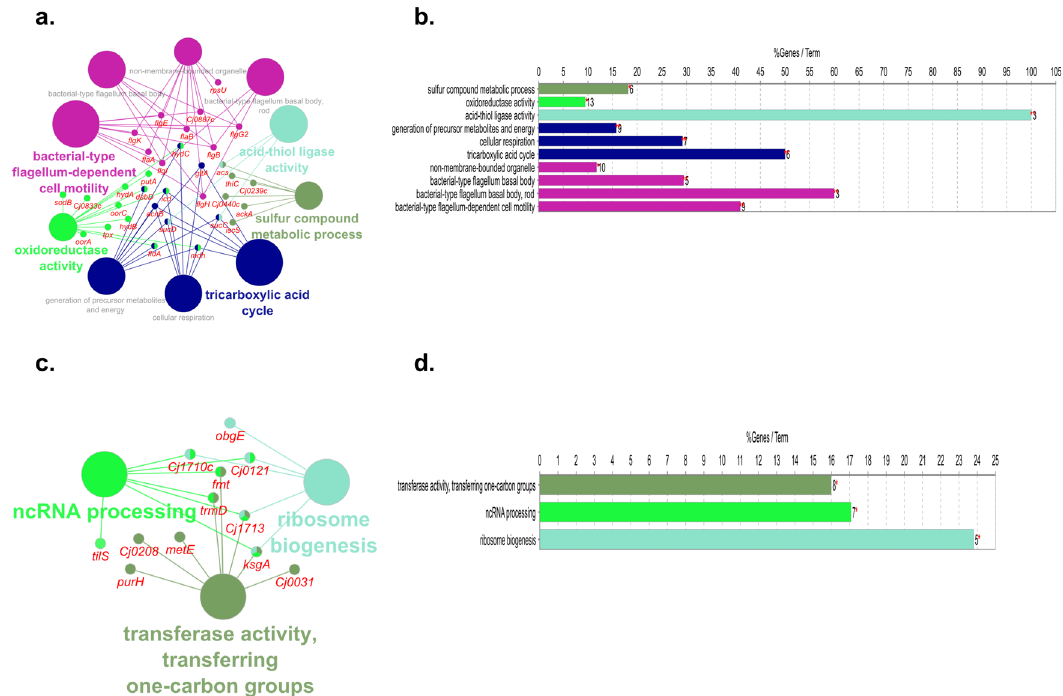
Fig. 3 Biological pathway analysis of DEGs in exposure to chlorine at 5 °C. Pathways enriched by mapping the upregulated ( a , b ) DEGs obtained from C. jejuni post-exposure to chlorine at 5 °C. Pathways enriched by the downregulated ( c , d ) DEGs obtained from C. jejuni post- exposure to chlorine at 5 °C. Only signi fi cantly ( P < 0.05) enriched pathways were obtained for biological pathway analysis of the regulated DEGs (FDR < 0.05; log 2 fold change >1 or < − 1) in ClueGO and CluePedia plugins in Cytoscape. In the graph, the length of individual bars indicates the percent of DEGs associated with respective terms out of the total associated